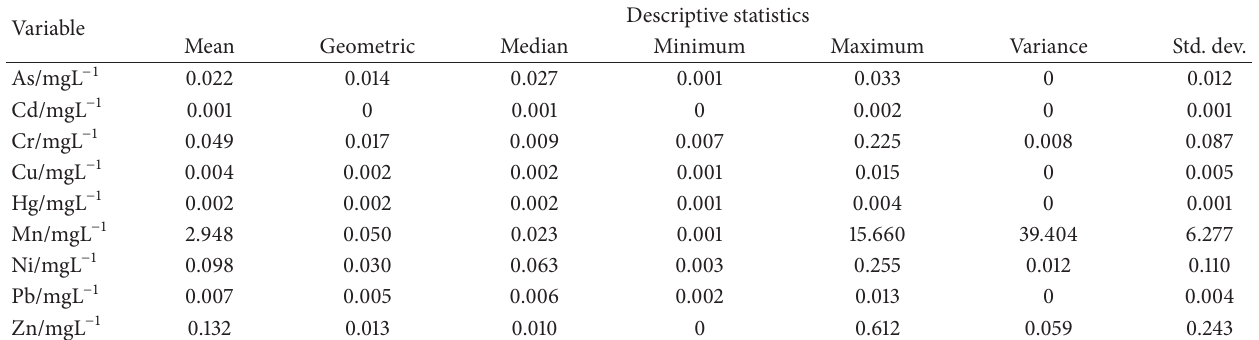
Table 4: Descriptive statistics of the 9 variables in 6 cases.